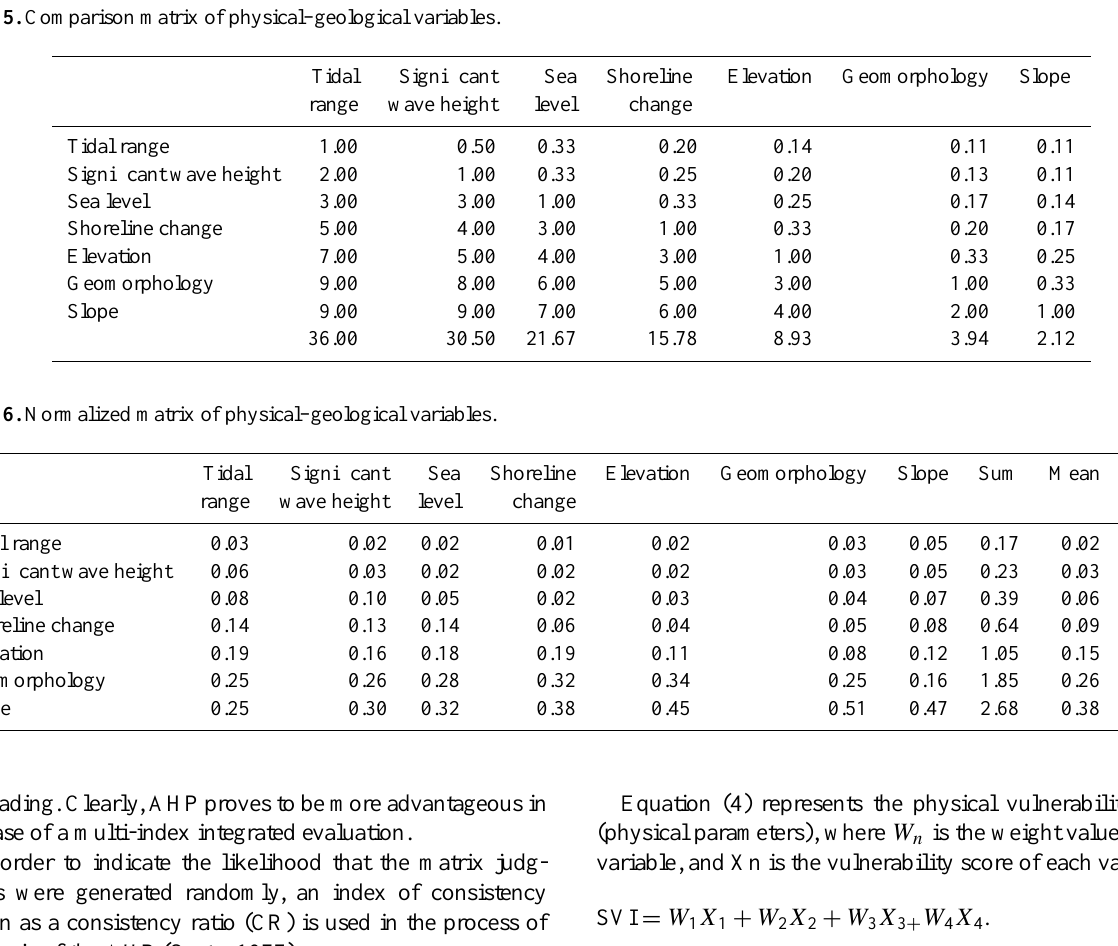
Table 5. Comparison matrix of physical–geological variables. Tidal Significant Sea Shoreline Elevation Geomorphology Slope range wave height change Tidal range